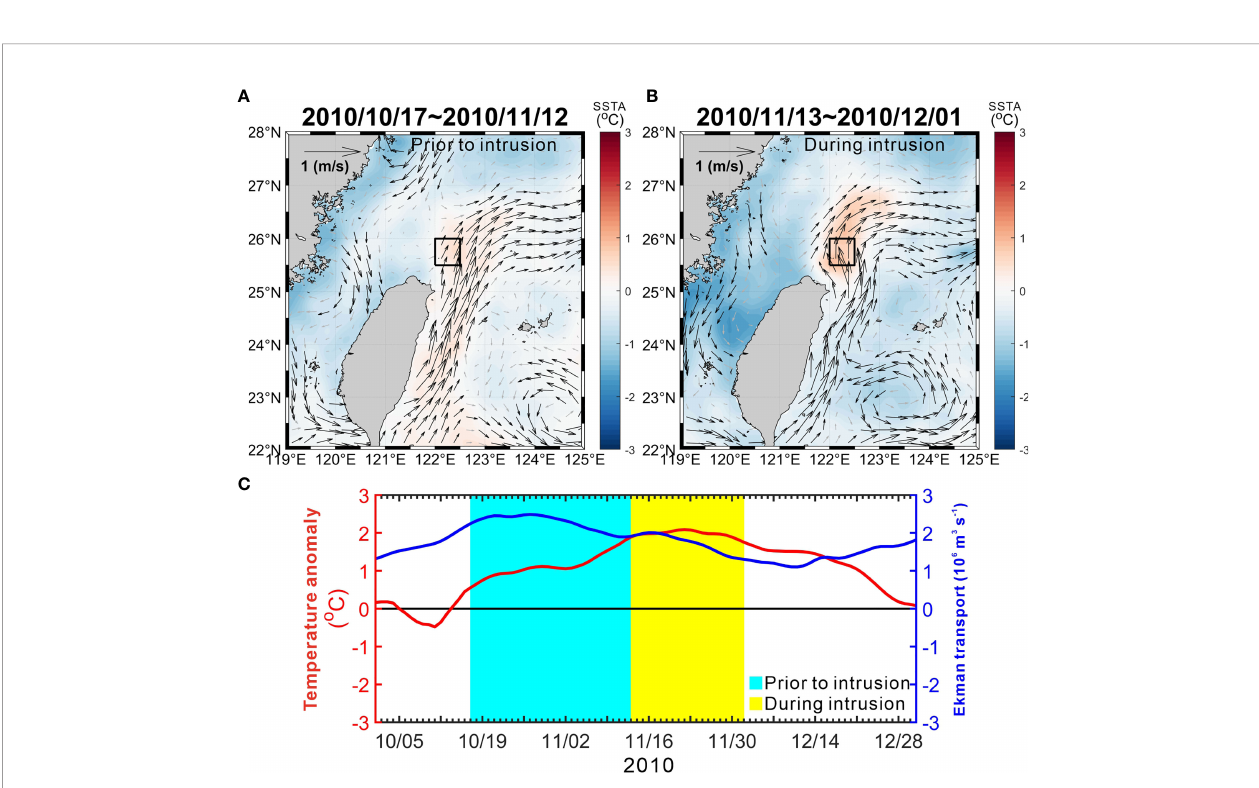
FIGURE 7 | The intrusion event dynamically contributed from the impinging eddy east of Taiwan and the northeasterly monsoon-induced northwestward (shoreward) Ekman transport. Satellite SSTa and SSH-derived geostrophic current (A) prior to the intrusion and (B) during the intrusion. Black arrows represent